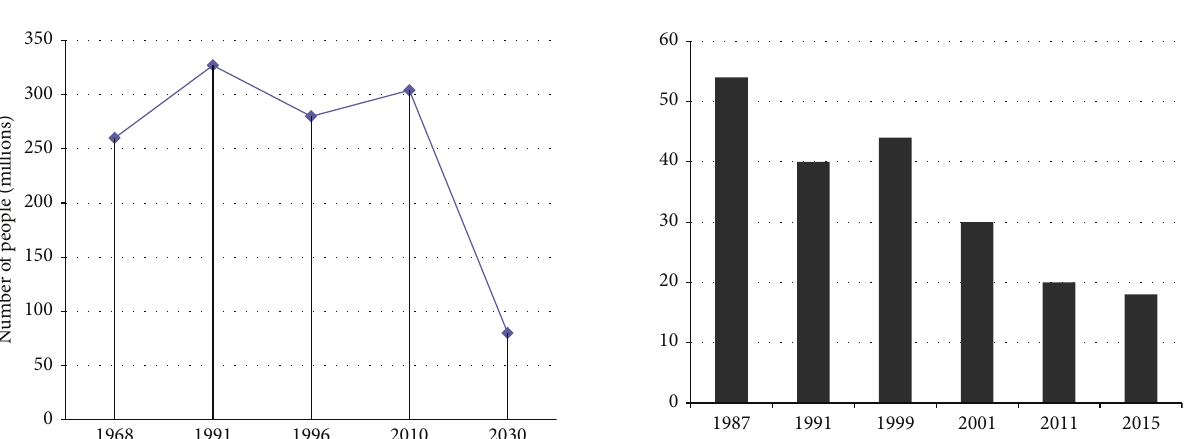
Figure 4: Food-insecure people in South Asia (millions). Source: (1) Global Hunger Index and (2) undernourishment statistics, 2013, http://www.worldometers.info/undernourishment/.